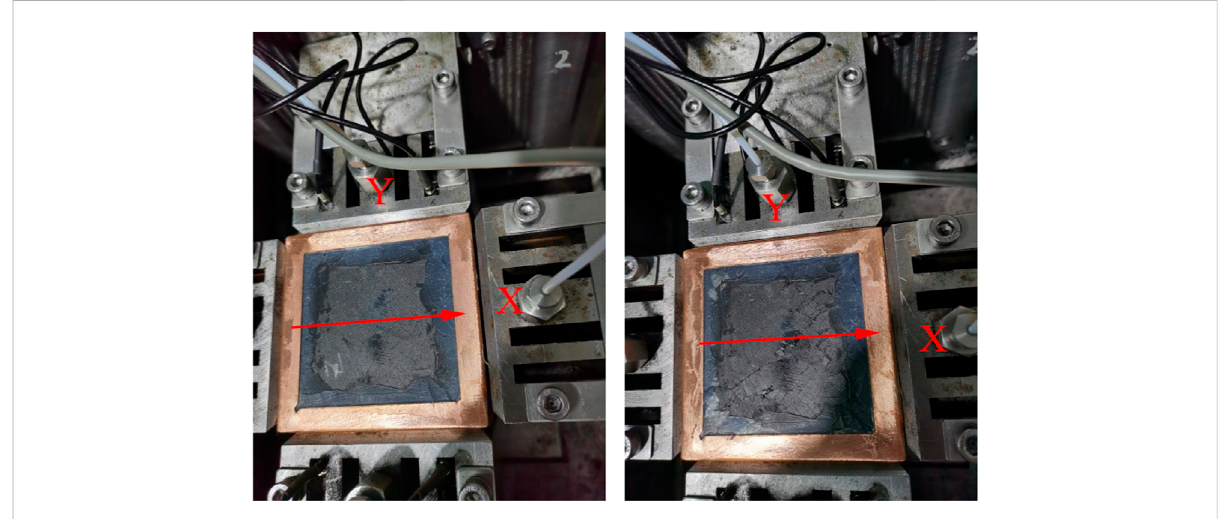
FIGURE 3 Coal sample before (left) and after (right) an axial compression permeability experiment. Note: The arrow stands for the gas seepage direction.